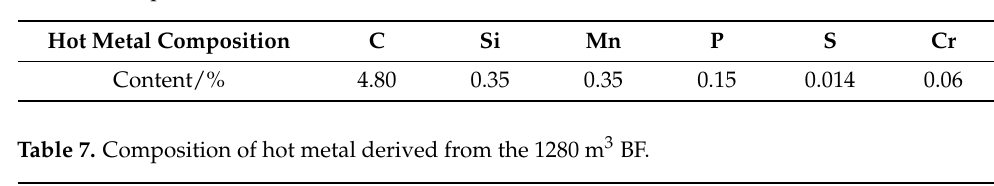
Table 6. Composition of hot metal derived from the 4350 m 3 BF.